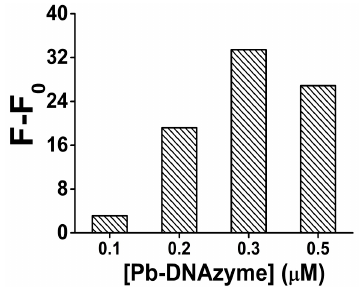
Figure 3. The optimization result of the Pb-DNAzyme concentration for Pb 2+ sensing in the presence of 100 nM Pb 2+ . [Pb-DNAzyme] is the concentration of Pb-DNAzyme. Original data for the optimization result of the Pb-DNAzyme concentration for Pb 2+ sensing shown in Figure S5.